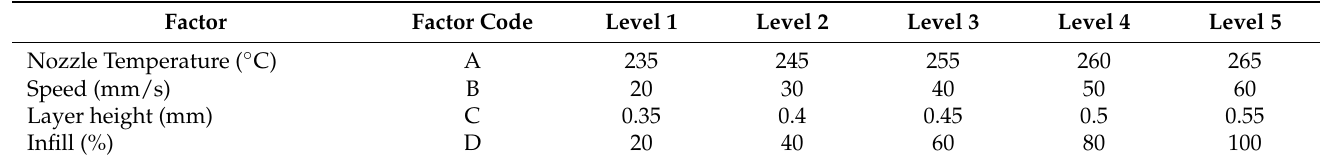
Table 3. Controllable factors and associated levels used in Taguchi experimental design for PETG+KF.